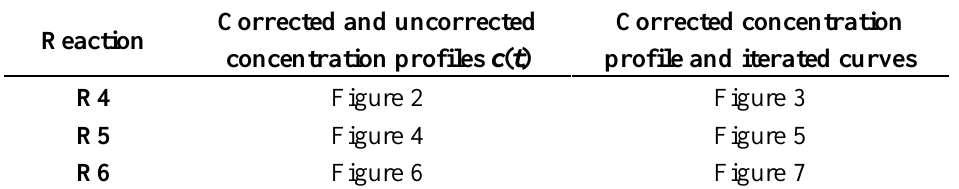
Table 3. Reactions R4 to R6 and the appropriate figures for the concentration profiles c ( t ) .